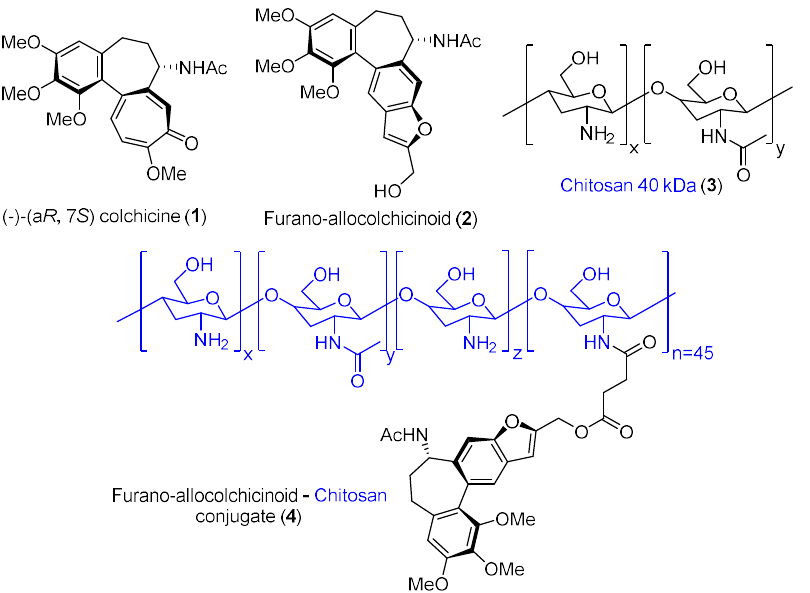
Figure 1. Structures of colchicine ( 1 ), furano-allocolchicinoid ( 2 ), chitosan 40 kDa ( 3 ) and furano- allocolchicinoid—chitosan conjugate ( 4 ) [7].